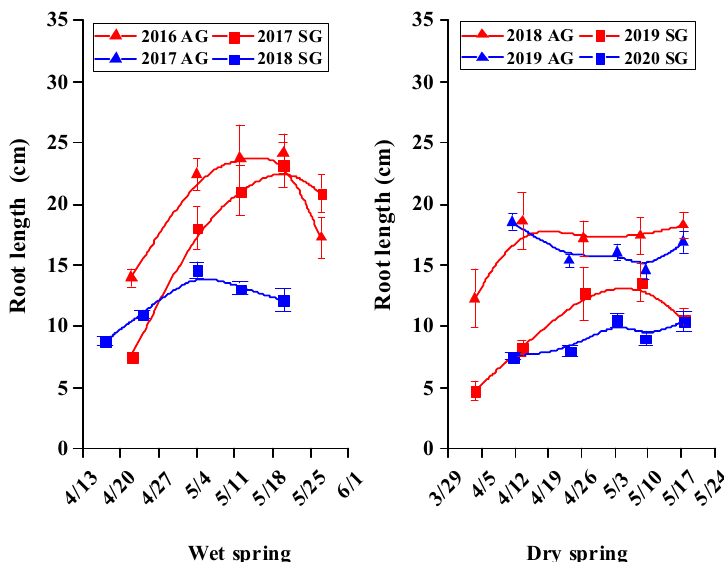
Figure 5. Increase in height of spring (SG)- and autumn (AG)-germinating plants of Erodium oxyrhinchum in wet ( left ) and dry ( right ). Vertical bars indicate standard errors of the means (n = 8).